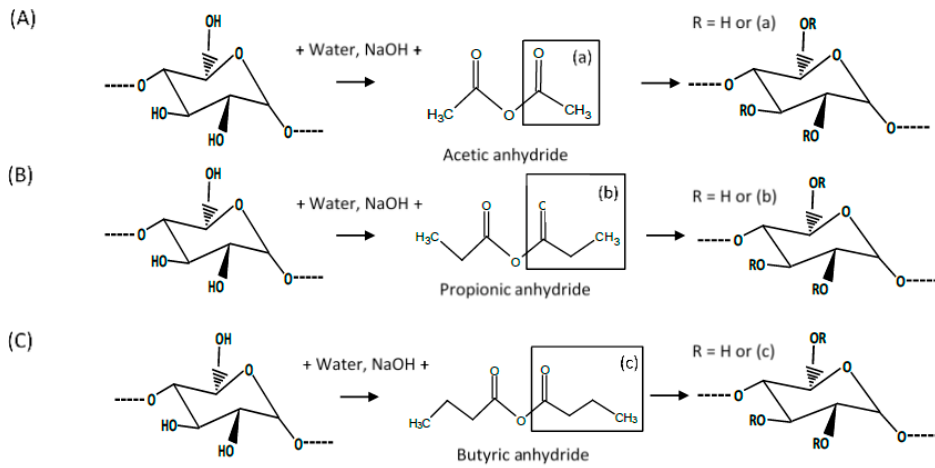
Figure 1. Schematic representation of the main reaction of starch acylation with short-chain fatty acid anhydrides (acetic, propionic, and butyric anhydride) ( A ) acetylation, ( B ) propionylation, and ( C ) butyrylation.